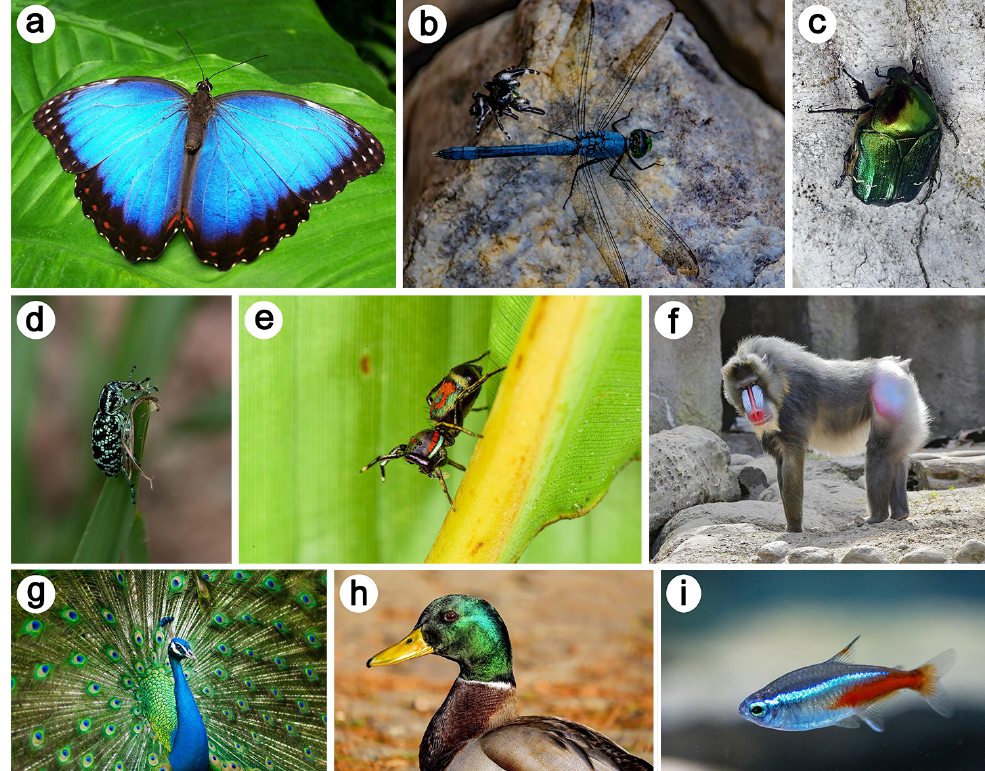
Figure 2. Many examples of structural colours are found in the integuments of natural organisms. They include the wings of the common morpho Morpho peleides ( a ), the body of some dragonfly species ( b ), the thorax and elytra of the green rose chafer Cetonia aurata ( c ), the body of the Botany Bay diamond weevil Chrysolopus spectabilis ( d ), the integuments of some jumping spider species ( e ), the skin of the mandrill Mandrillus sphinx ( f ), the feathers of the Indian peafowl Pavo cristatus ( g ), the head of the mallard Anas platyrhynchos ( h ), and the body of the neon tetra fish Paracheirodon innesi ( i ). Reproduced from from https://pixabay.com/ accessed on 27 July